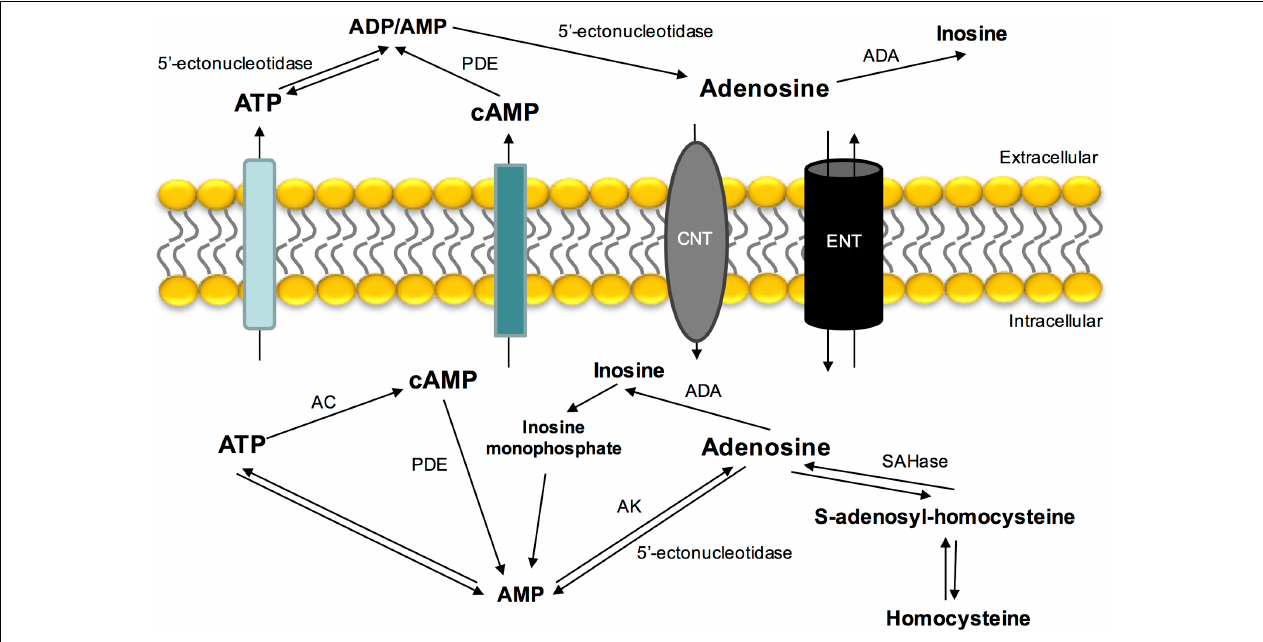
FIGURE 1 | Extra- and intracellular adenosine metabolism and nucleoside transporters that contribute to its release, uptake and production. ADA, adenosine deaminase; AC, adenylyl cyclase; AK, adenosine kinase; CNT, concentrative nucleoside transporter; ENT, equilibrative nucleoside transporter; PDE, phosphodiesterase; SAHase, S -adenosyl homocysteine